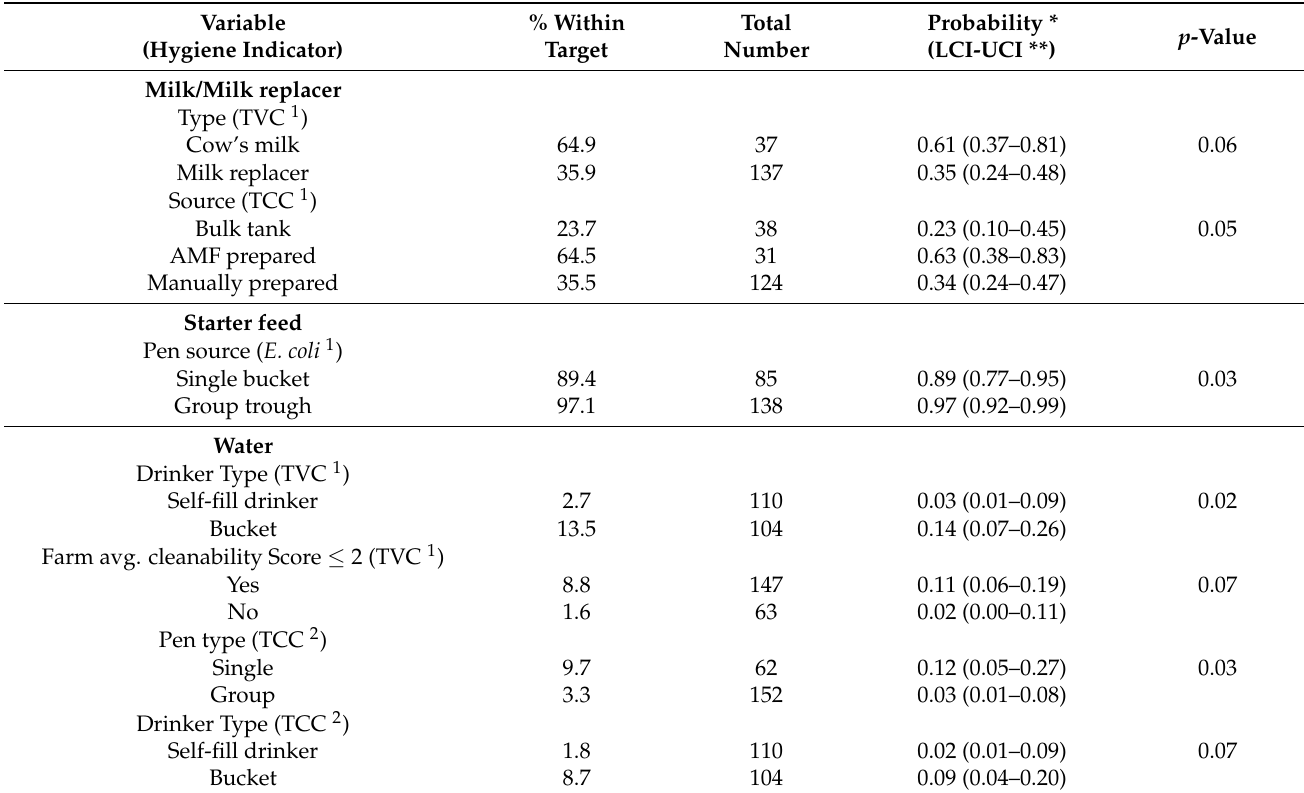
Table 3. Sample source and farm housing and management factors for liquid and solid feed offered to calves that impacted the likelihood of meeting hygiene indicator targets.